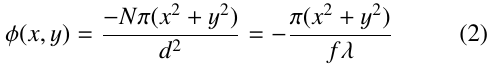
the mDOE, ML and the subtracted